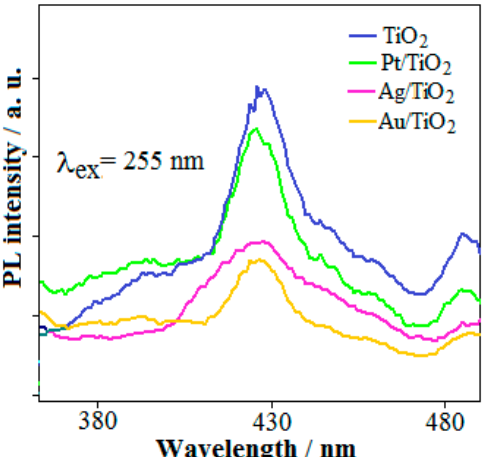
Figure 5. Comparative PL emission spectra of bare and metal-loaded TiO 2 . Experimental conditions: 0.5 mg catalysts suspended by ultrasonication in 3 mL of water.